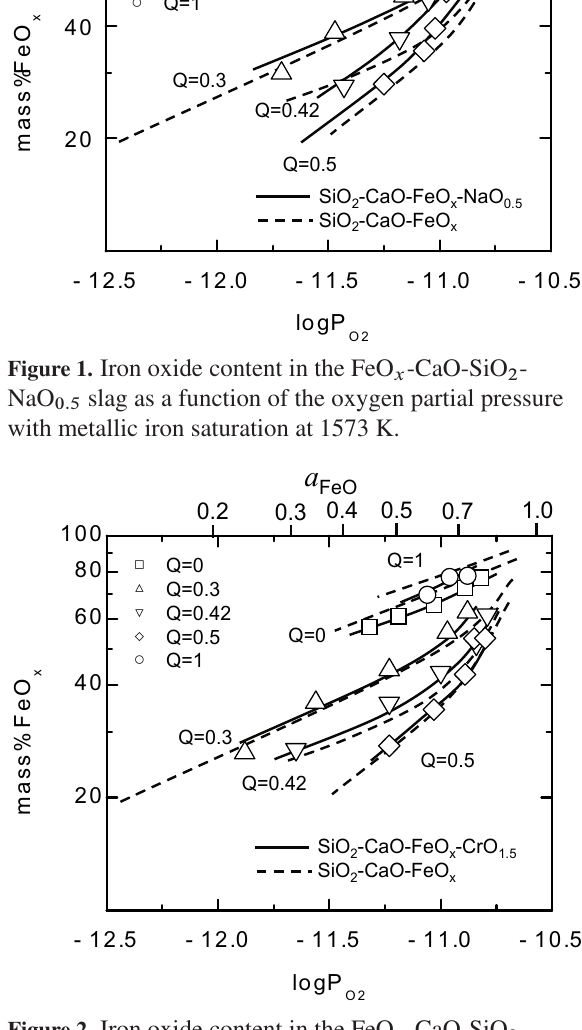
Figure 2. Iron oxide content in the FeO x -CaO-SiO 2 - CrO 1:5 slag as a function of the oxygen partial pressure with metallic iron saturation at 1573